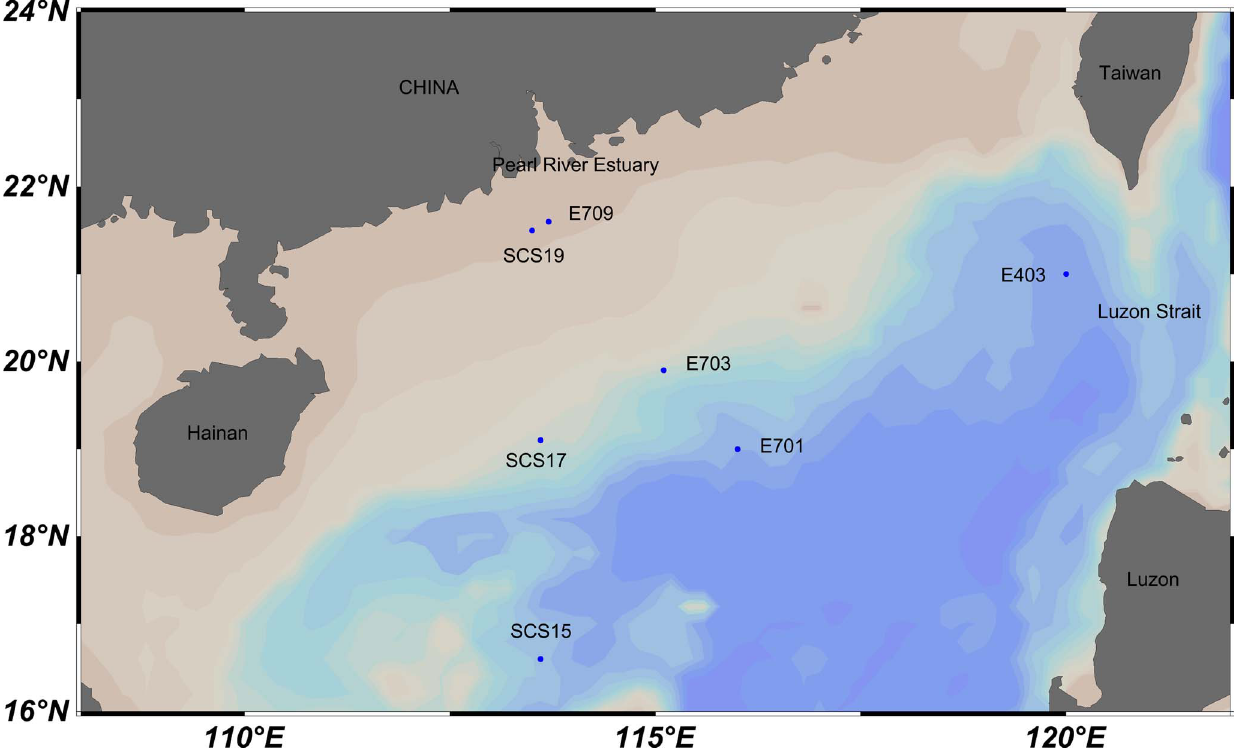
Figure 1. Map of sampling stations in the northern South China Sea.